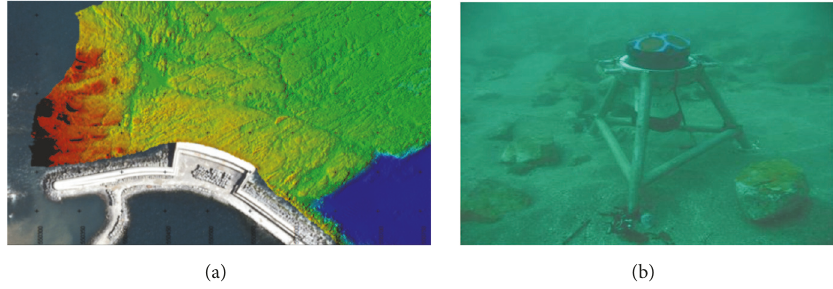
Figure 9: (a) Wave spectrum record. (b) RDI